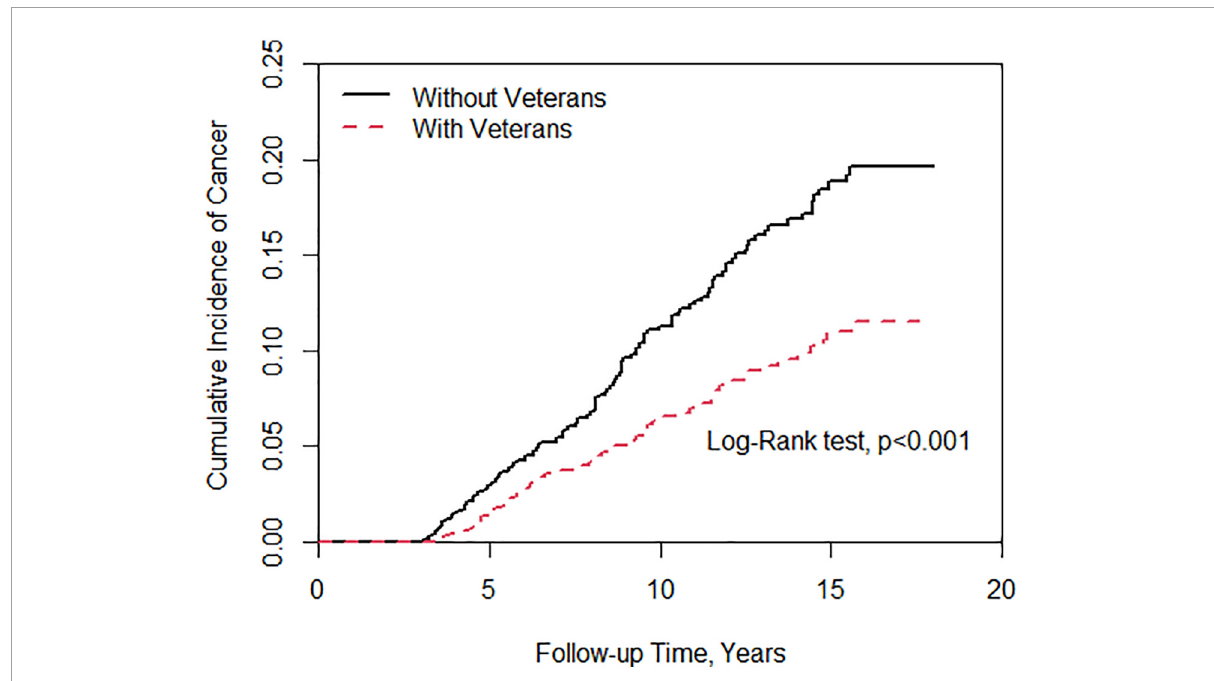
FIGURE1 Cumulative incidence of cancer between individuals with and without veteran status.